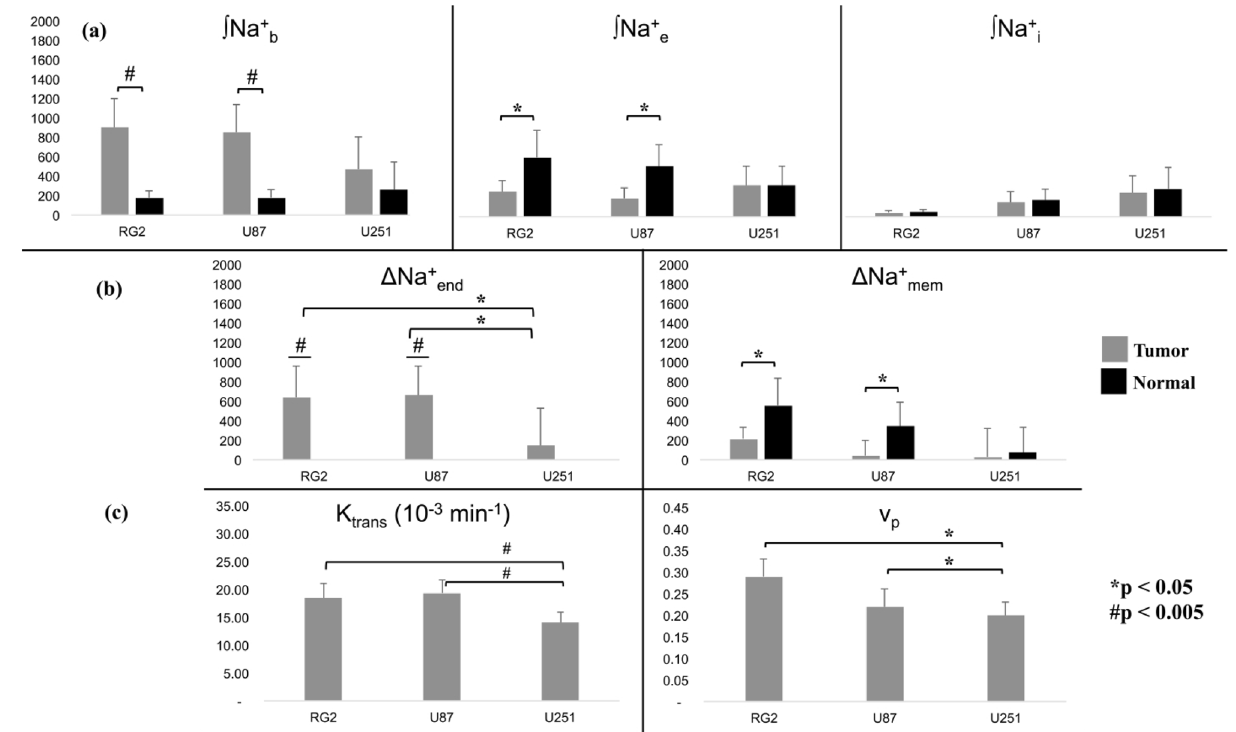
Figure 6. Statistical comparisons between intracellular, extracellular, and vascular compartments across RG2, U87, and U251 tumors with 23 Na-MRSI and 1 H-DCE-MRI. ( a ) Relation between ∫Na + b , ∫Na + e and ∫Na + i across tumor and healthy tissues. For the RG2 and U87 tumors, the ∫Na + b values were significantly higher than normal tissue ( p < 0.005, #). Also for these tumors, the ∫Na + e values were significantly lower than normal tissue ( p < 0.05, *). The mean values for the U251 tumor roughly followed the same trend but were not significant. Furthermore, there was no significant difference between ∫Na + i values in tumor and normal tissues for any of the three tumor types. ( b ) Relations between tumor and normal tissues for ∆Na + end and ∆Na + mem for the three tumor types. Tumor ∆Na + end values were significantly larger than normal values ( p < 0.005, #), which were non-positive (data not shown). Moreover, ∆Na + end in RG2 and U87 tumors was significantly greater than in the U251 tumor ( p < 0.05, *), indicative of vascular differences between the tumor types. ∆Na + mem values were, on average, weaker in tumor compared to normal tissue, but significant only in RG2 and U87 tumors ( p < 0.05, *). Based on Figs. 5 and S5, it is clear that the relation between ∆Na + end and ∆Na + mem is negative. ( c ) 1 H-DCE- MRI data for the volume transfer coefficient ( K trans ) and plasma volume fraction ( v p ) values, which are known to reveal information regarding vascular structure and function. K trans follows the same patterns as ∫Na + b and ∆Na + end across tumor types. K trans ( p < 0.005, #) and v p ( p < 0.05, *) were both significantly larger in RG2 and U87 tumors, compared to U251. See Figure S6 for the plasma flow rate ( F p ) and the extracellular volume fraction ( v parameters for individual animals from each tumor